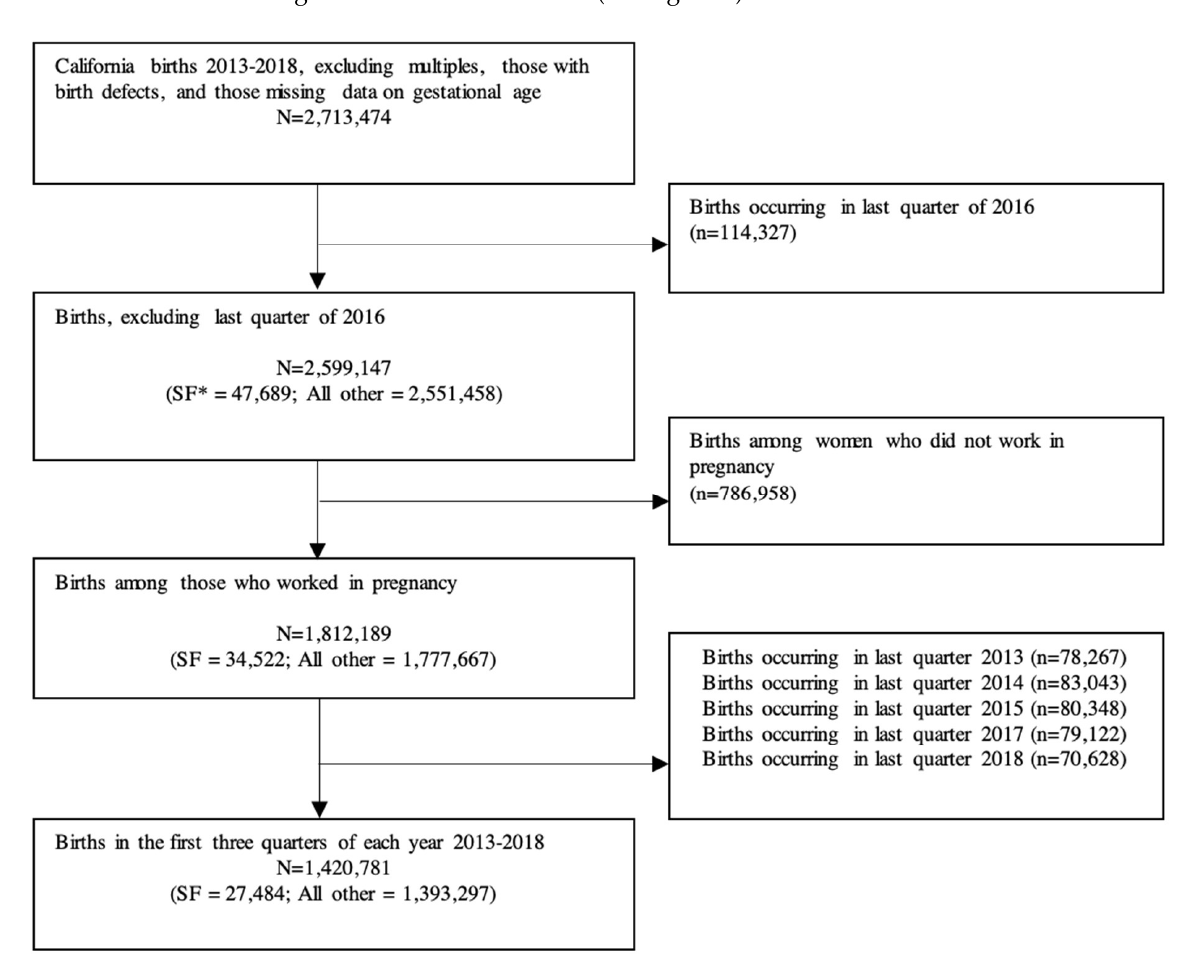
Figure 1. Study Figure 1. Study Exclusions.